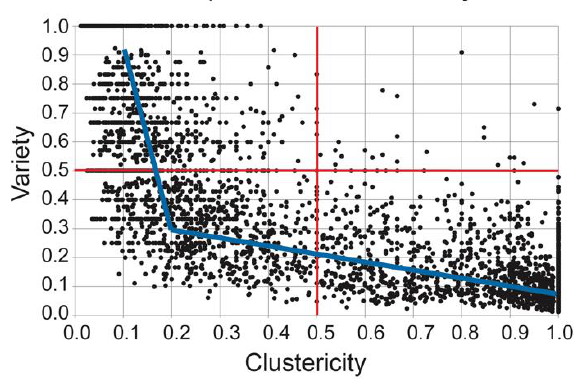
Figure 4. High clustericity and high variety is rare among OLS trajectories. A comparison of the haloarchaeal OLS trajectories revealed a large distribution of behavior with respect to clustericity and variety. In the above plot, each data point is a single context trajectory. Red lines segregate into 4 quadrants based on high or low clustericity paired with high or low variety. Note that the quadrant (high clustericity and high variety) is sparsely populated compared to the other three quadrants. This suggests that when many OLS gene content modifications occur (high variety), a large number of singleton gene states are also observed (decreased clustericity). A blue line is drawn to indicate a two-part piecewise fit. We propose that this model may be used to explain the path of a singleton gene evolving into a large, conserved OLS: initially, there is an exploratory phase (left blue line), where rapid formation of OLSs and dissolution of OLSs may occur until a stable OLS is formed, after which a long phase of tuning and refinement may follow (right blue line).